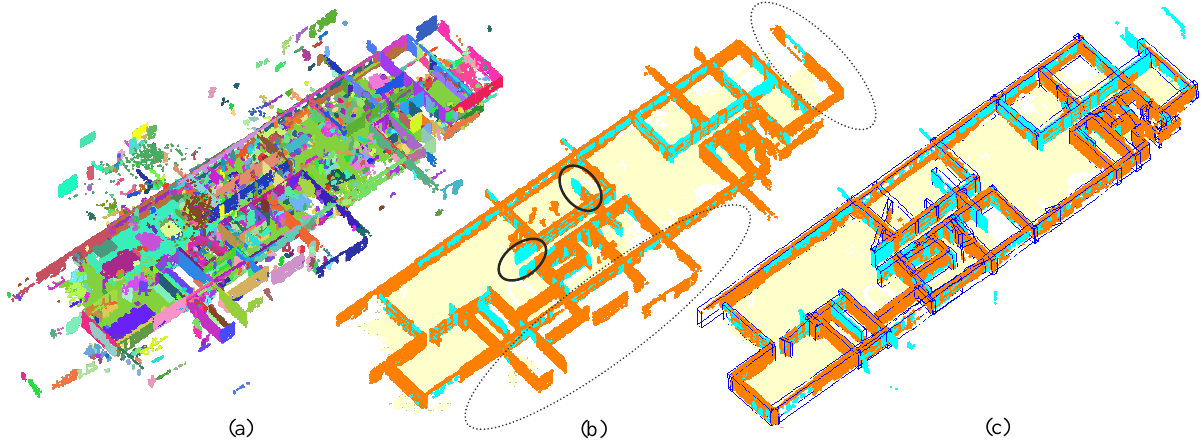
Figure 8. The images show the input and output of section three. The algorithm takes laser point clouds as input and exports labeled laser points including walls, openings, floor, ceiling and clutter. (a) Cluttered 3D point clouds of a building story acquired by Zeb1. (b) Detected walls (orange) and openings (cyan) in the first iteration. Black dot ovals show incorrect walls outside the building footprint. Black solid ovals show incorrect detected openings (fake openings). (c) Detected walls and openings in second iteration after automatically removing points outside the building footprint. Blue boxes show the extent and thickness of the